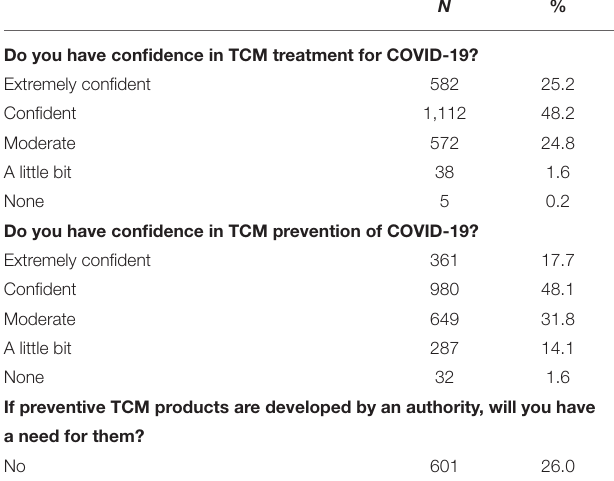
TABLE 6 | Characteristics and COVID-19 prevention knowledge and practice correlated with concerns about resuming work.